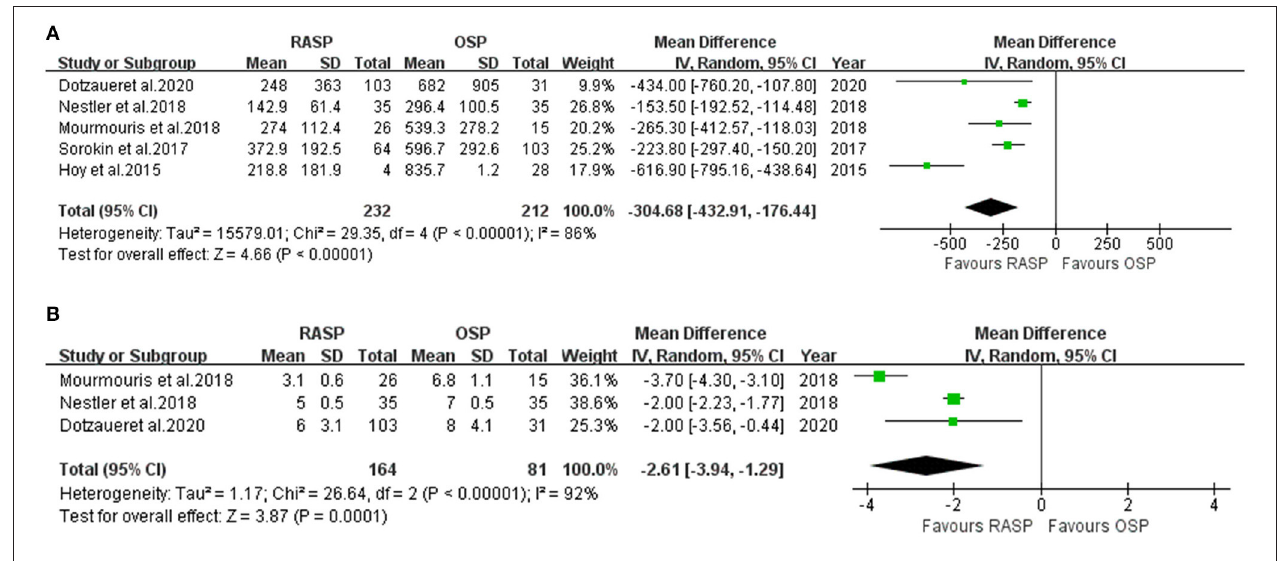
FIGURE 3 | Forest plot and meta-analysis of EBL (A) and CT (B) .